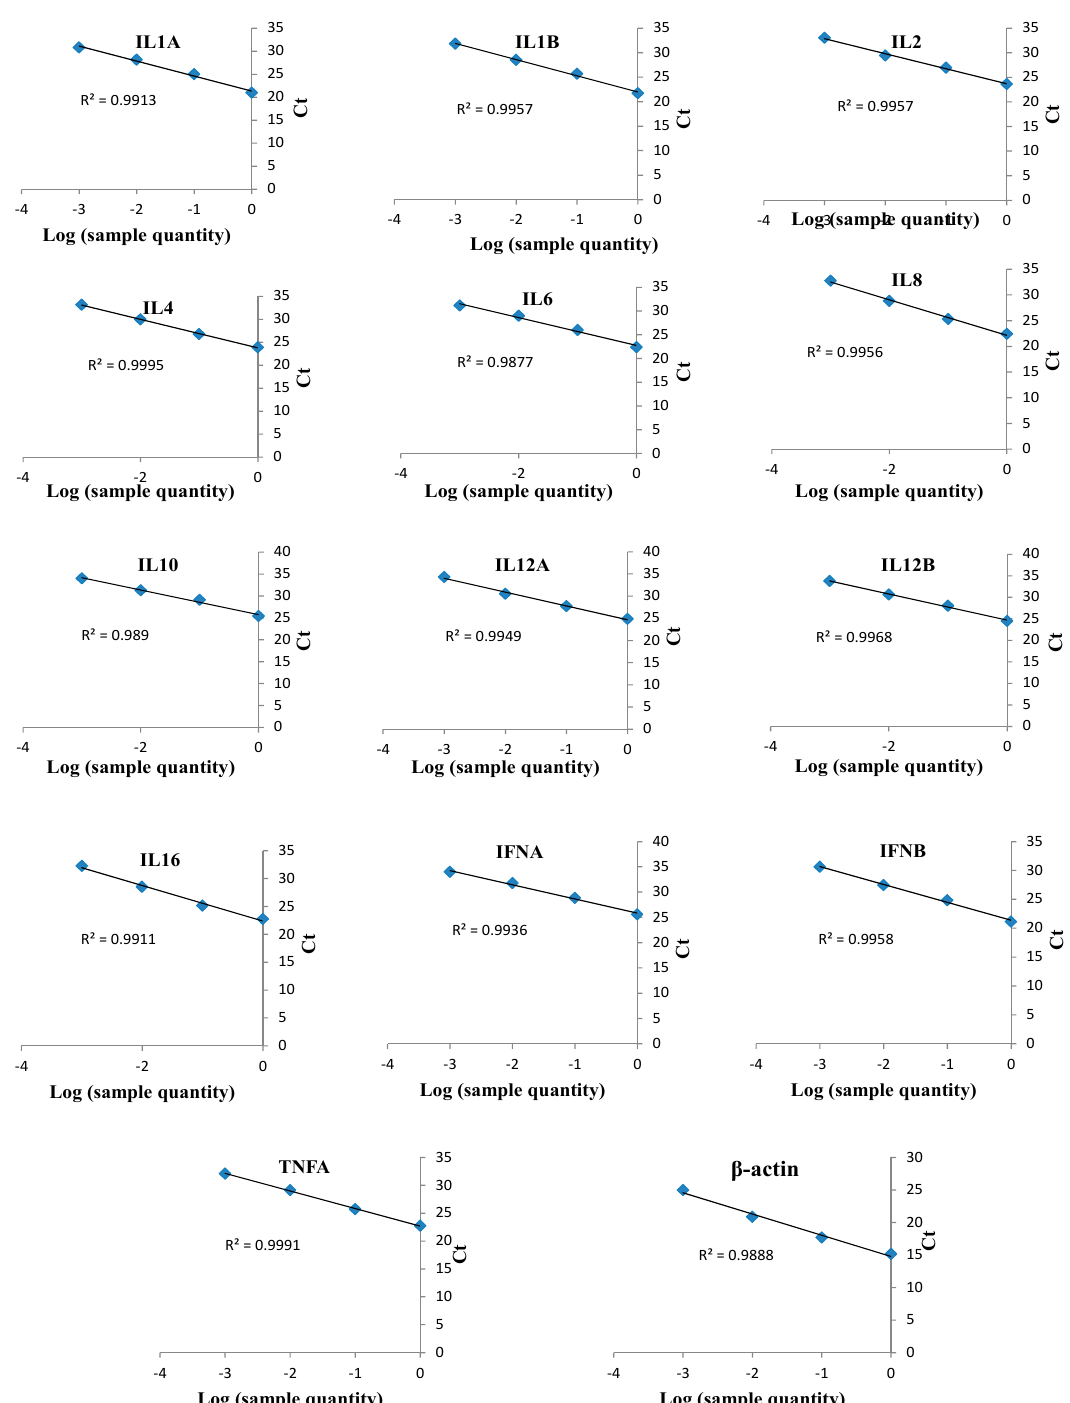
Figure 8. qPCR linearity measurements of bovine cytokines in cDNA from T. annulata -transformed B cells (TaBCs) and LPS-stimulated peripheral blood mononuclear cells (PBMCs). qPCR was performed on serially diluted (1/10) cDNA to detect and optimize the efficacies of various cytokine primers. These optimized primers were used to evaluate the transcript levels of cytokine in TaBCs, BW720c-treated transformed B cells, and LPS-stimulated normal B cells (nBCs) and TaBCs. The qPCR data were analyzed by regression analysis based on log values of sample quantity and threshold cycles (Ct) for each cytokine. The monitored cytokines and R 2 values of each regression line are shown.